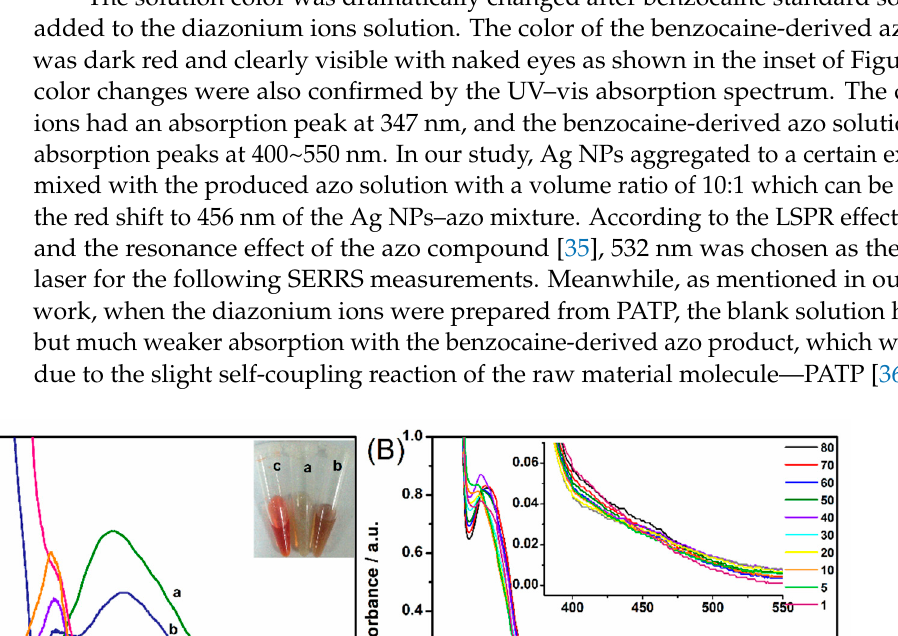
Figure 2. Azo coupling reaction between diazonium ions and benzocaine.